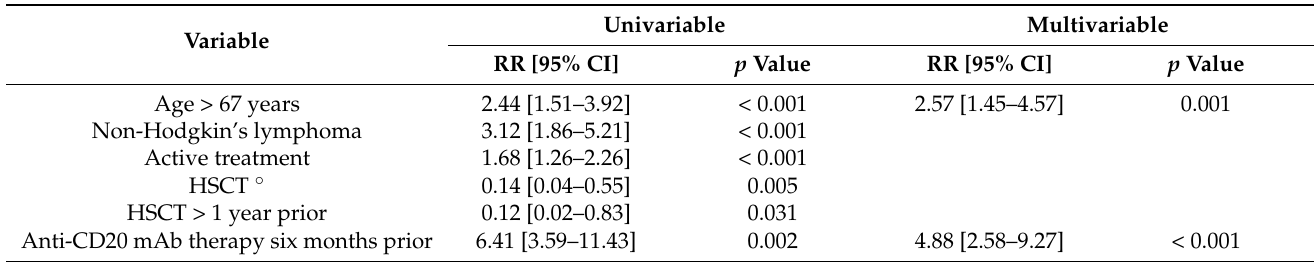
Table 2. Significant predictors of no humoral response in patients who received two vaccine doses were determined at an α level of